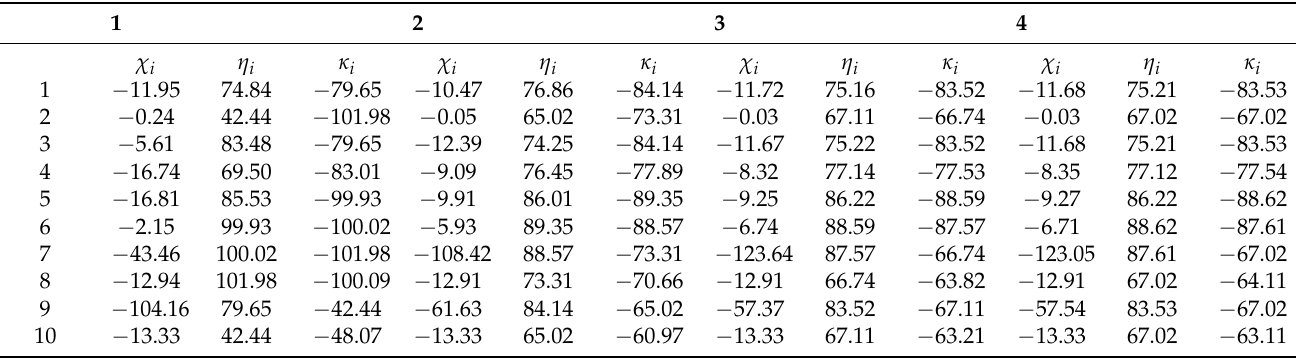
Table 3. Derivative values over iterations.